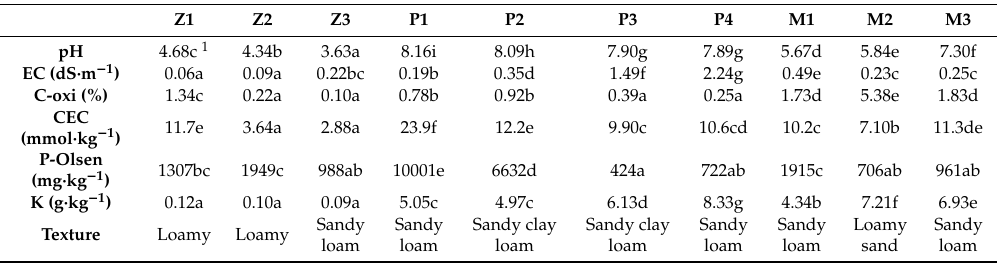
Table 2. Main properties of soils.